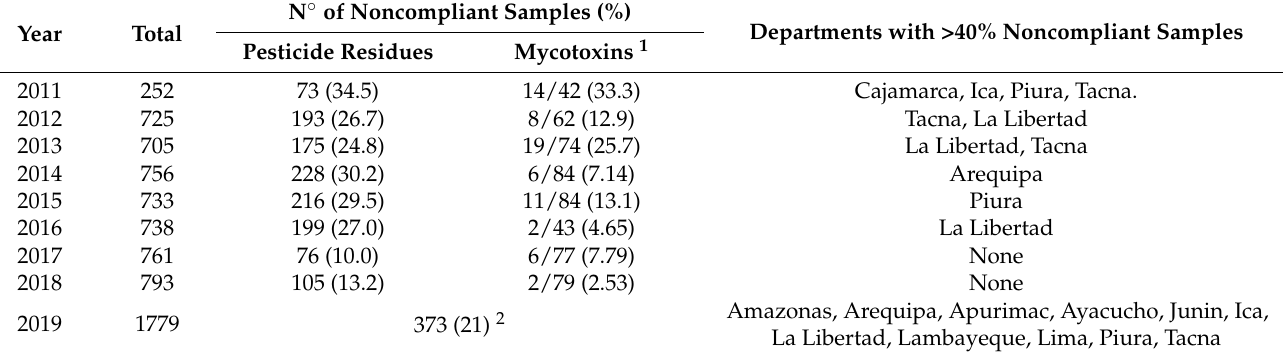
Table 4. Chemical compliance of samples of plant origin monitored from 2011 to 2019 in Peru. Table adapted from annual reports by the National Service of Agrarian Health agency